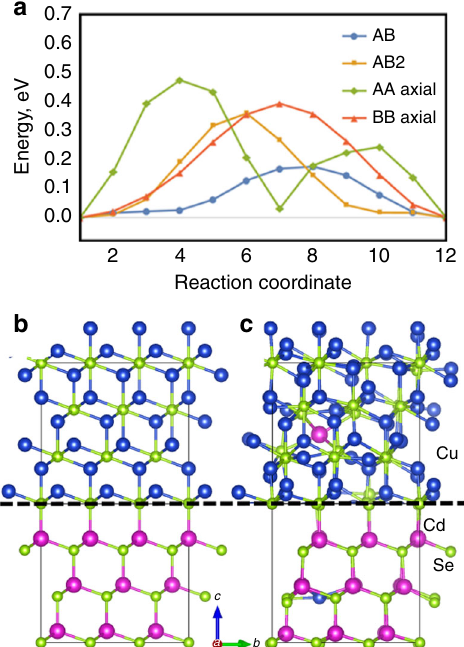
Fig. 4 Computational modeling. a Energy barriers along the Cu + diffusion paths in wurtzite CdSe structure, as calculated using the NEB method (see also Supplementary Figure 6c). The radial diffusion is dominated by successive AB steps, while the axial diffusion is facilitated by alternating AB and AB2 steps. b , c Scheme of the CdSe – Cu 2 Se interface (illustrated with a dashed line) with anti fl uorite Cu 2 Se above and zinc blende CdSe below. The structures with defects were obtained by structural optimization and then brought together to illustrate the